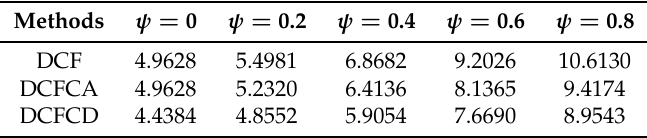
Table 1. Position ARMSE of different colored noises.